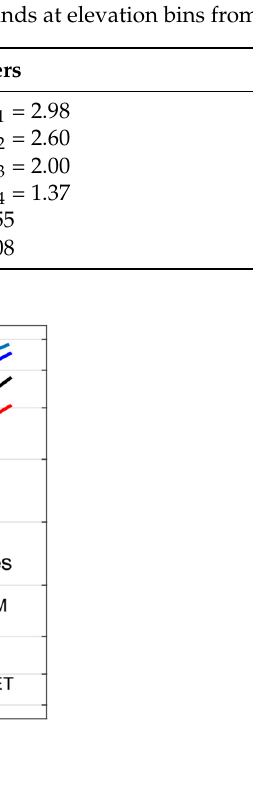
Figure 6. CDFs of the Ifree-based range errors and overbounds for an elevation bin from 15° to 20°. The y -axis is scaled to show the tails.